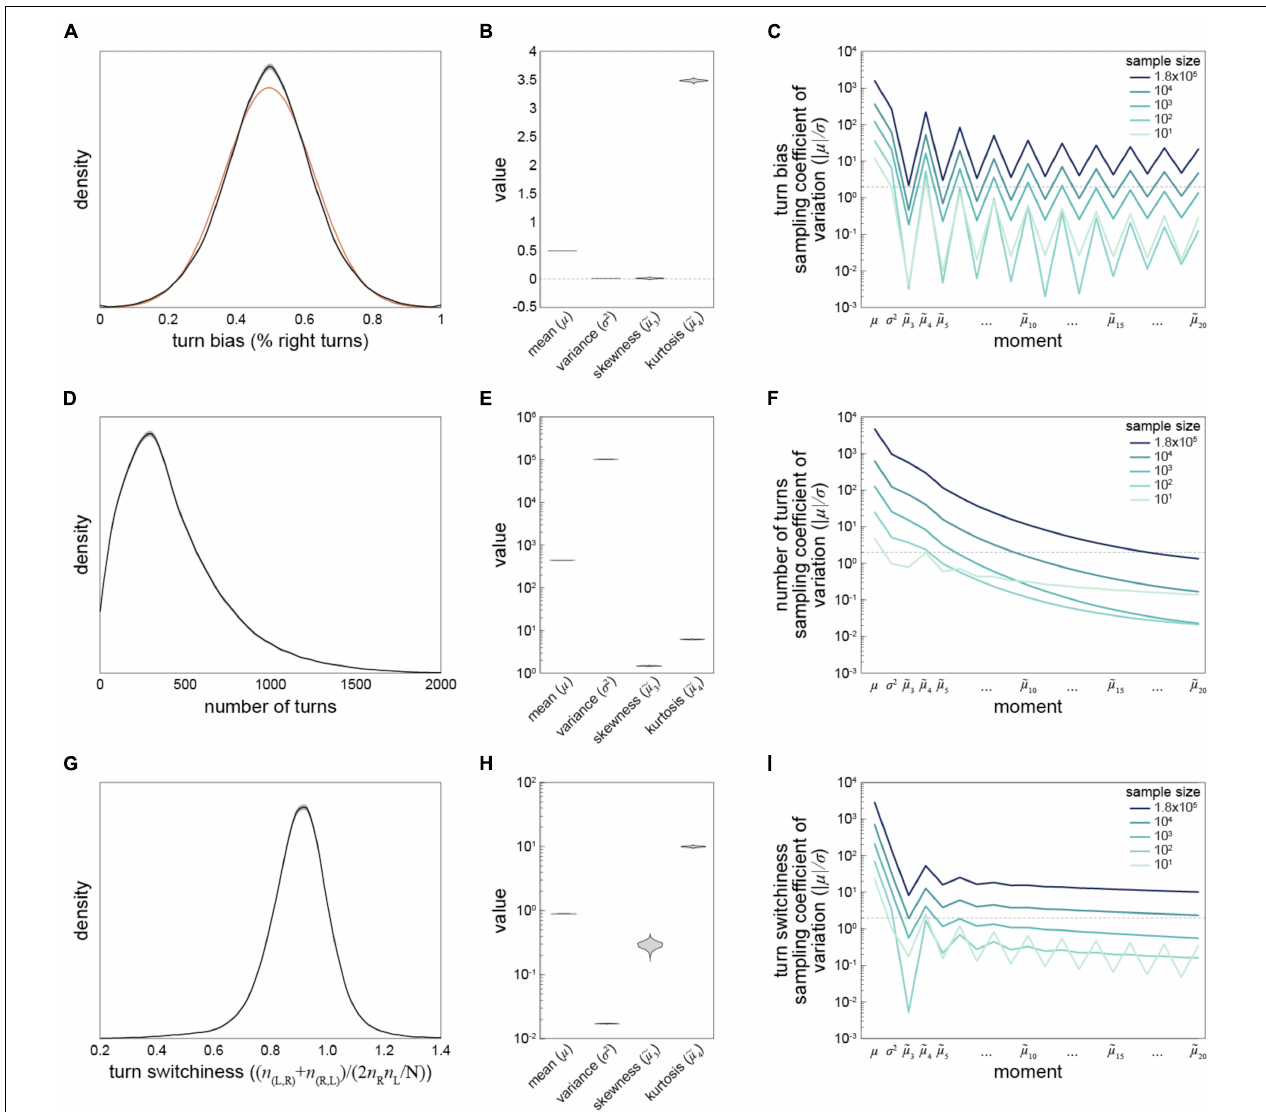
FIGURE 2 | Estimation of statistics describing three Y-maze behavioral measures— (A) Kernel density estimate of the distribution of turn bias across all flies in the data set. Gray interval is the 95% CI as estimated by bootstrap resampling. Orange line is the Gaussian distribution that best fits the data. (B) Violin plot of estimation distributions of four statistical moments describing the distribution of turn bias. Each violin is a kernel density estimate of the distribution of each statistic’s value across bootstrap samples from 1,000 replicates. (C) Average bootstrap estimate of the mean, variance, and subsequent 18 standardized moments of the distribution of turn bias, as a function of the size of the data set. Darkest line corresponds to the complete grand Y-maze data set, and lighter lines random subsets. Dotted line at | µ | / σ = 2 indicates the threshold for moment estimate significantly different from 0 at p = 0.05. (D–F) As in panels (A–C) for number of turns as the behavioral measure. (G–I) As in panels (A–C) for turn switchiness as the behavioral measure. Note log y-axes in panels (C,E,F,H,I) . Data from all 183,496 flies were used in these